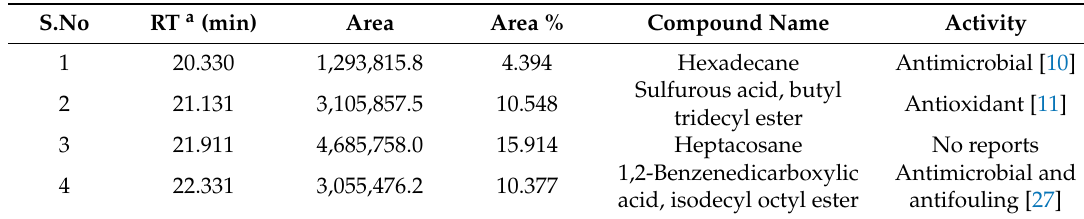
Table 5. Chemical constituents GC-MS analysis of A. nilotica seed essential